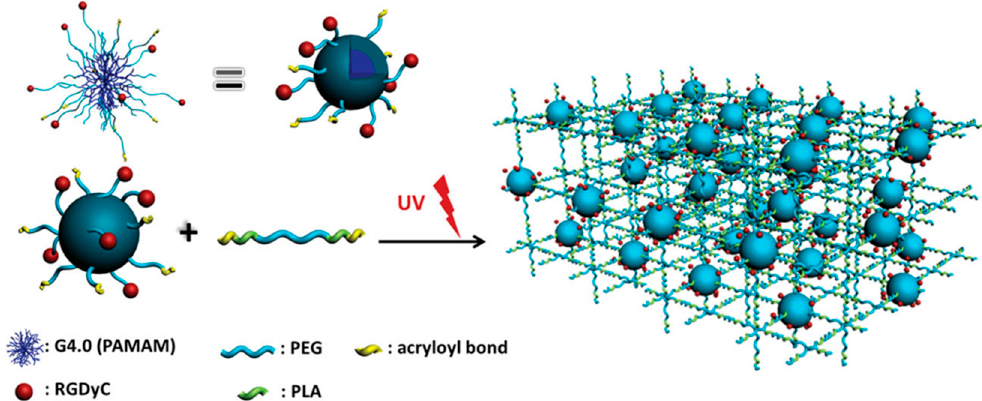
Figure 23. Schematic description of the hydrogels based on diacrylate-terminated poly(ethylene glycol)- b -poly(lactic acid) (PEG-PLA-DA) and the modified PAMAM dendrimer. From [53], Copyright © 2014 by John Wiley & Sons, Inc. Reprinted by permission of John Wiley & Sons, Inc. RGDyC, arginine-glycine-(aspartic acid)-( D -tyrosine)-cysteine.